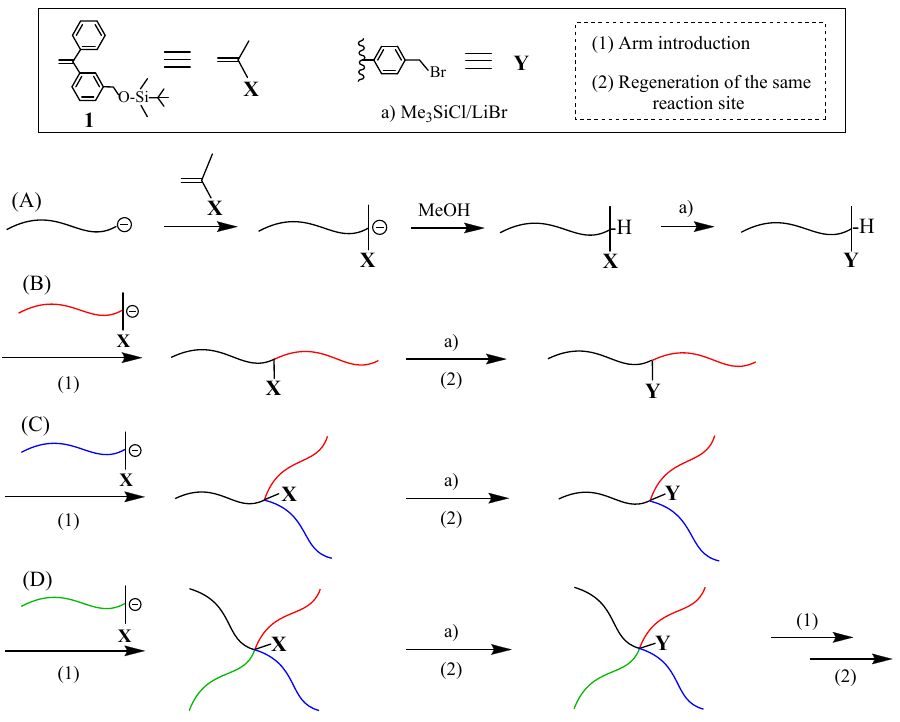
Table 1. All of the polymers possessed the well-controlled M n values and compositions and extremely low polydispersity indexes. The successful syntheses of the requisite ABC and ABCD ( µ -SP)s are thus obvious. Table 1. Characterization results of ( µ -SP)s synthesized by the iterative methodology.